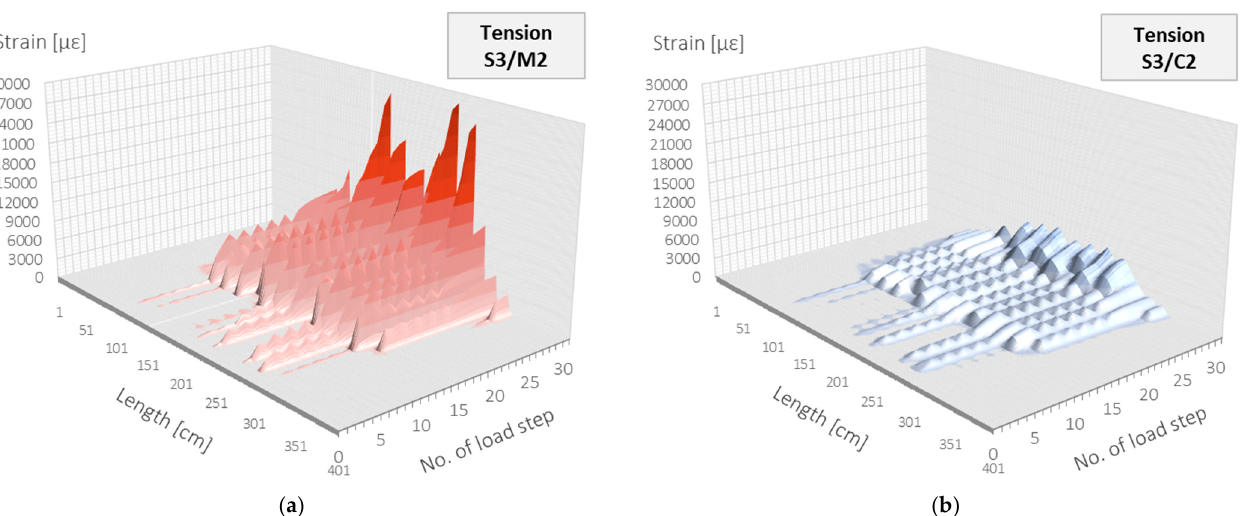
Figure 15. Beam S3/tension zone: strain profiles in length and load step domain registered by ( a ) monolithic sensor M2 and ( b ) layered sensing cable C2 with steel strengthening insert.